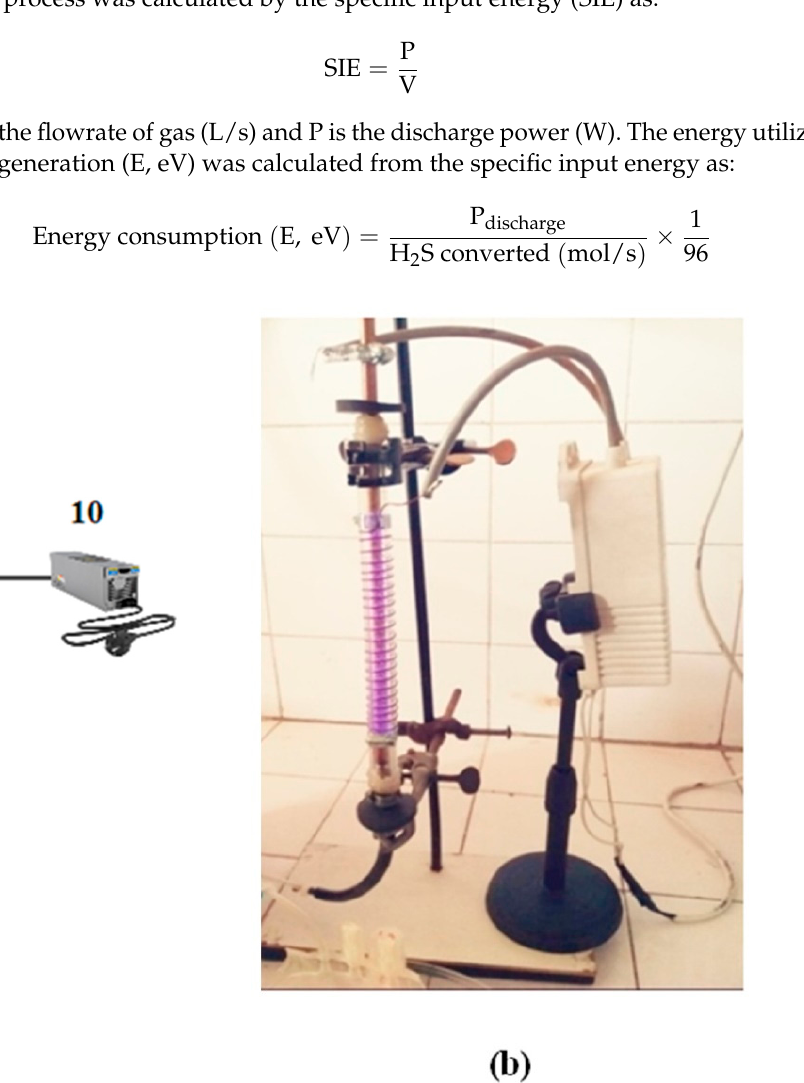
Figure 2. ( a ) Schematic of DBD plasma system. (1) Gas cylinder, (2) Gas supply, (3) Hole in rod, (4) Quartz tube, (5) Inlet, (6) Outlet, (7) Inner electrode, (8) Copper coil, (9) Gas sampling bag, and (10) AC power supply. The arrows indicate the direction of the gas flow (H 2 S and Ar). ( b ) Photographic view of single-layered DBD plasma system for H 2 S decomposition.